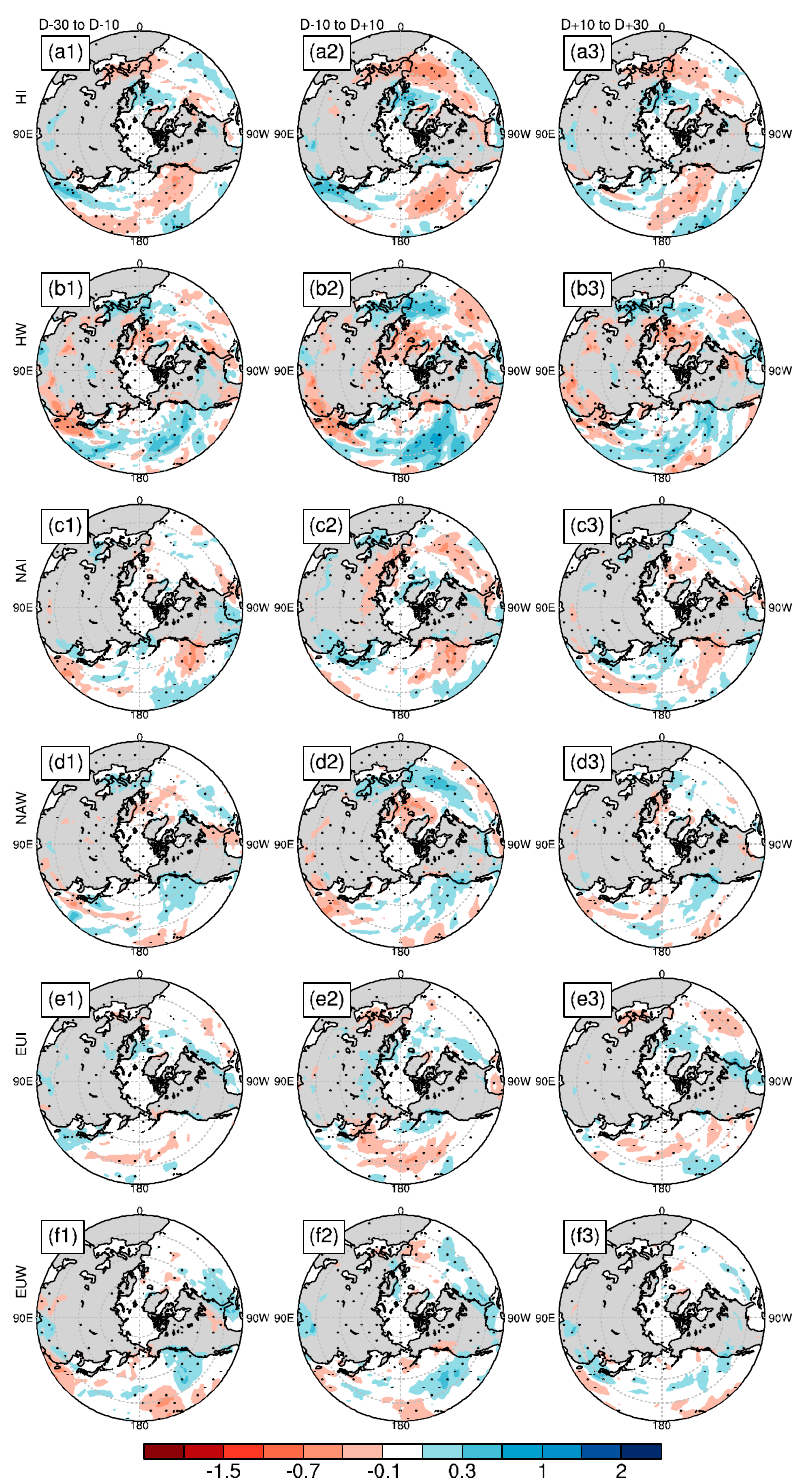
Figure 7. Composited leading/lagging evolutions of precipitation anomalies (shadings; units: mm/d) from 20 to 90°N during three stages of the six stratospheric Arctic vortex weather regimes. ( a1 – f3 ) The clusters 1-6 are printed as HI, HW, NAI, NAW, EUI, and EUW regimes, respectively. The first column displays the average for days − 30 to − 10, the second column displays the average for days − 10 to 10, and the third column displays the average for days 10 to 30. The dotted area indicates the composited anomalies significant at the 99% confidence